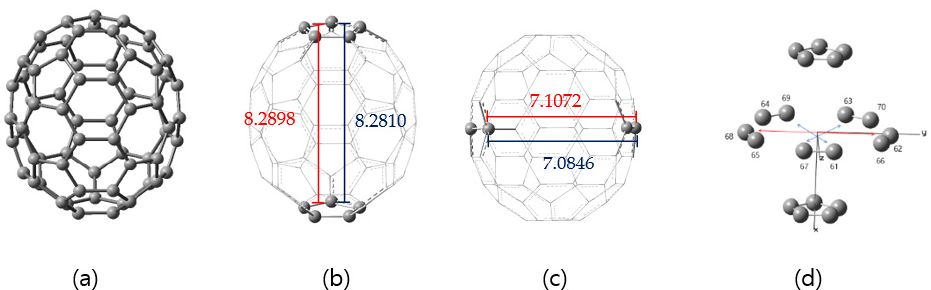
Figure 5. ( a ) The ball and stick structure of C 70 fullerene skeleton. ( b ) Distances (Å) between two pentagons of the top and bottom poles and for the diameter of the minor axis on the equatorial zone are: ( b ) 8.281 and ( c ) 7.085 for neutral C 70 and ( b ) 8.290 and ( c ) 7.107 for the C 70 anion. The major axis and the minor axis are represented by x and y (or z), respectively. ( d ) The cartesian coordinates and the length of the y-axis on the equator for C 70 fullerene skeleton were shown.